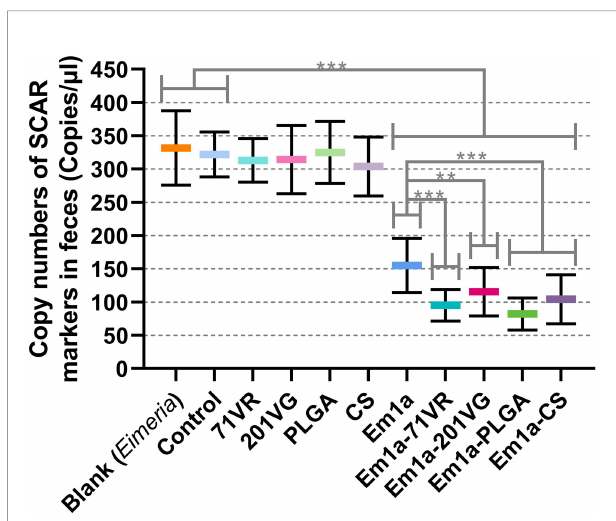
FIGURE 11 | E. mitis oocyst burdens in the feces of immunized chickens. Each animal was orally challenged with 3,000 puri fi ed E. mitis oocysts 1 week after the booster immunization. Six days later, feces excreted by each animal were collected for DNA extractions, and each extract was run in triplicate (n = 10). Values were estimated using one-way ANOVA followed by Dunnett ’ s test. Comparisons among Em1a, Em1a-71VR, Em1a-201VG, Em1a-PLGA, and Em1a-CS group were conducted by ANOVA following Bonferroni ’ s correction. Values were presented as the mean ± SD (n = 30). In all studies, ** p < 0.01 and *** p <